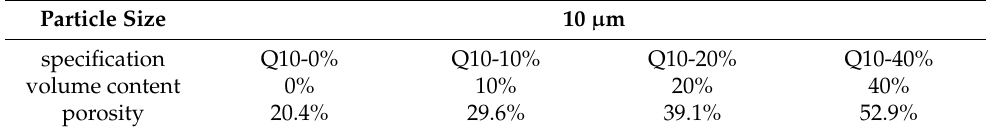
Table 2. Parameters of microchannels sintered with 10 µ m spherical copper powder.